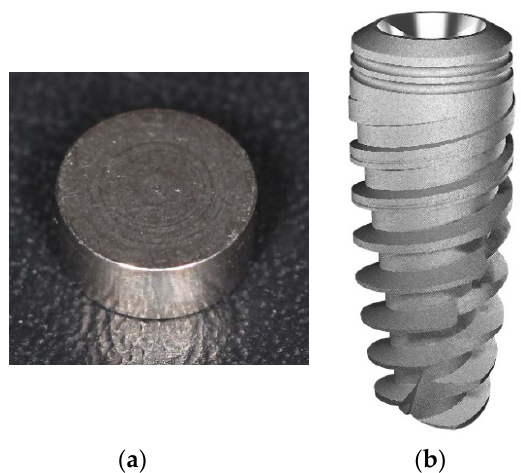
Figure 1. Representative image of the titanium disk ( a ) and the titanium implant; ( b ) macrodesign used for all sample groups.